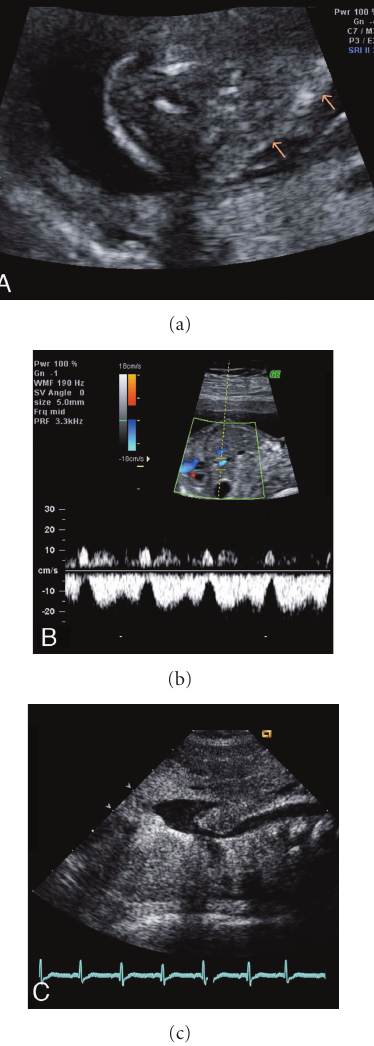
Figure 1: Ultrasound images prenatally and postnatally. (a) Fetal scan at the 12th week of pregnancy demonstrating moderate nuchal edema and cystic hygroma. (b) Pathological flow of the venous duct at the 20th week. During atrial contractions, a reverse flow is notice- able. (c) Two-dimensional echocardiogram of a newborn with absent SVC. The azygos and the hemiazygos veins have fused, and the venous duct formed is draining into the IVC.